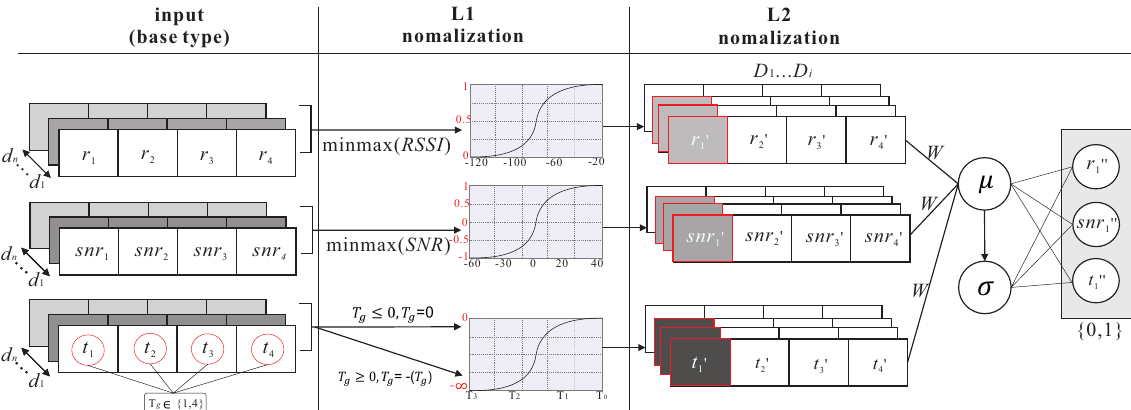
Figure 7. The normalization process for different